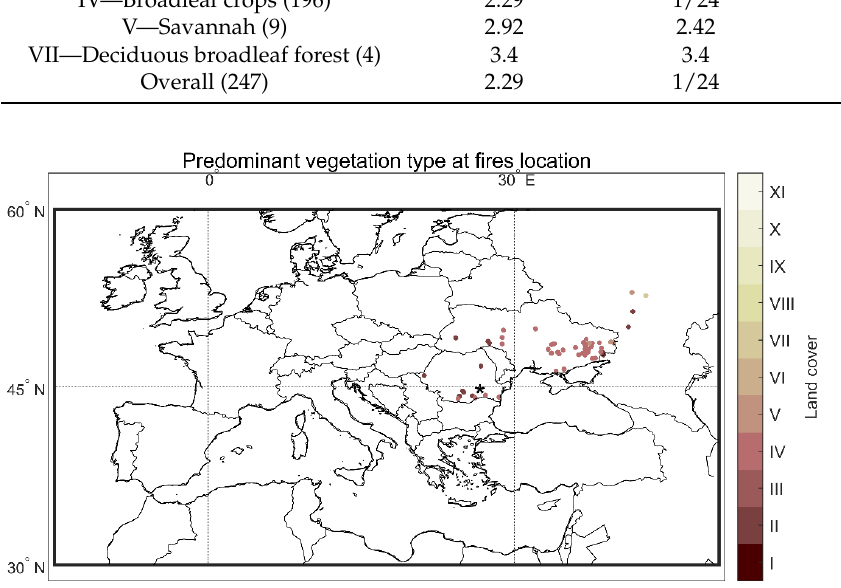
Figure 6. The vegetation type (land cover) at the fires’ location. The numbers for land cover correspond to: I — water (0%), II — grasses or cereal (15.4%), III — shrubs (0%), IV — broadleaf crops (79.4%), V — savannah (3.6%), VI — evergreen broadleaf forest (0%), VII — deciduous broadleaf forest (1.6%), VIII — evergreen needleleaf forest (0%), IX — deciduous needleleaf forest (0%), X — unvegetated (0%), XI — urban (0%). The lidar measurement site is shown by a black star.